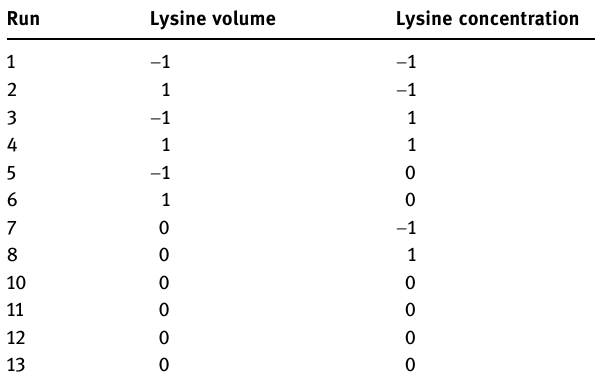
Table 3: Statistical design for the optimization of volume and concentration of lysine